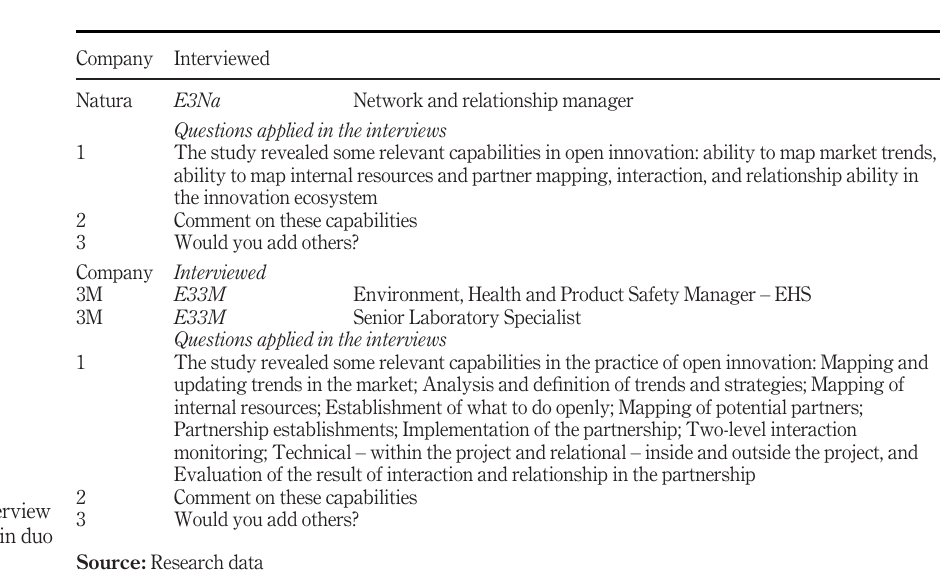
at Natura and in duo